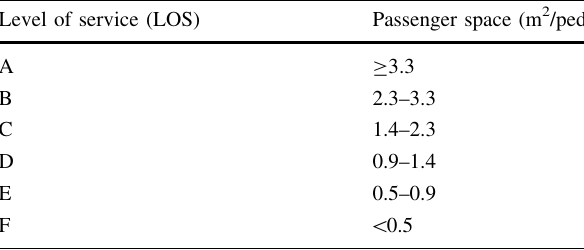
Table 1 Passengers level of service (LOS) on the walkway [1] Level of service